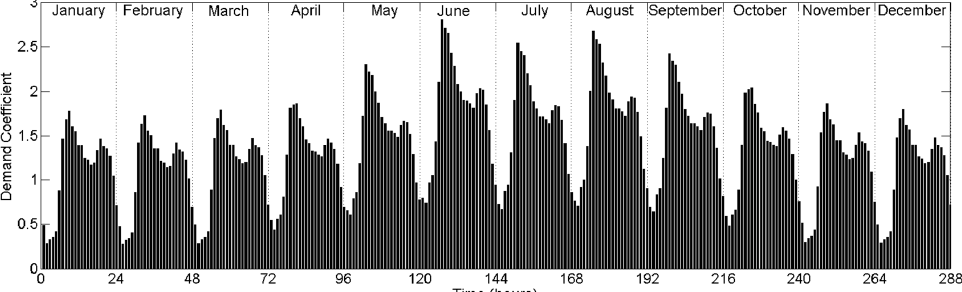
Figure 4. Hourly demand pattern representing one year.